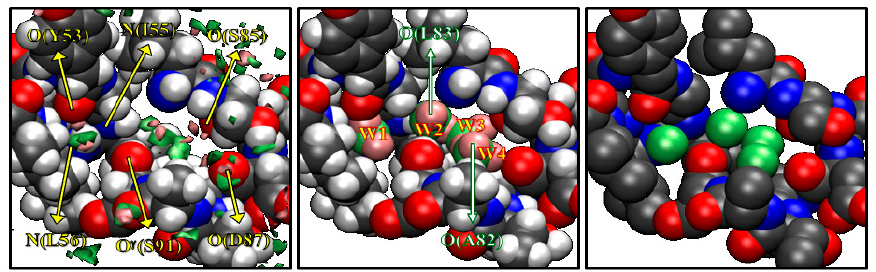
Figure 3. The 3D-distribution g( r ) of water inside the active site of protein: green surface, oxygen; purple surface, hydrogen. (The figure is reprinted from Ref. [46]. Copyright (2005) American Chemical Society.)